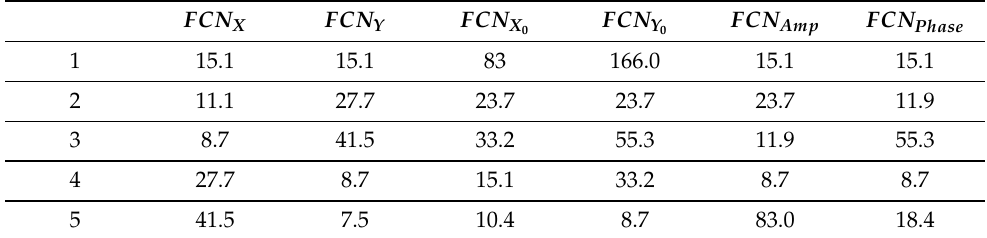
Table 3. Spectral analysis of the first derivative of FCN time series (after changing the resolution from daily to monthly): first five dominant frequencies (unit: months). FCN